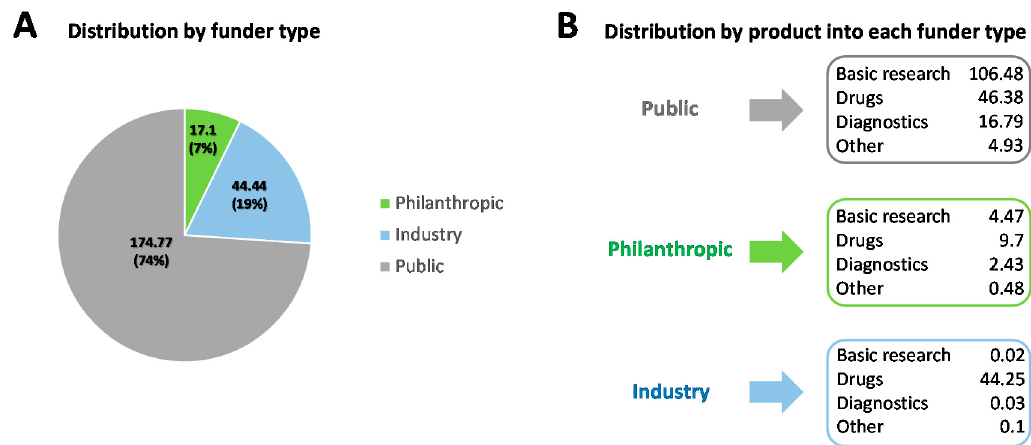
Figure 2. ( A ) Funds invested in Chagas disease for 10 years by the three main investment sectors. ( B ) Funds from the three main investment sectors distributed by product each type [20]. *The values are adjusted for 2018 inflation and are expressed in US million dollars.